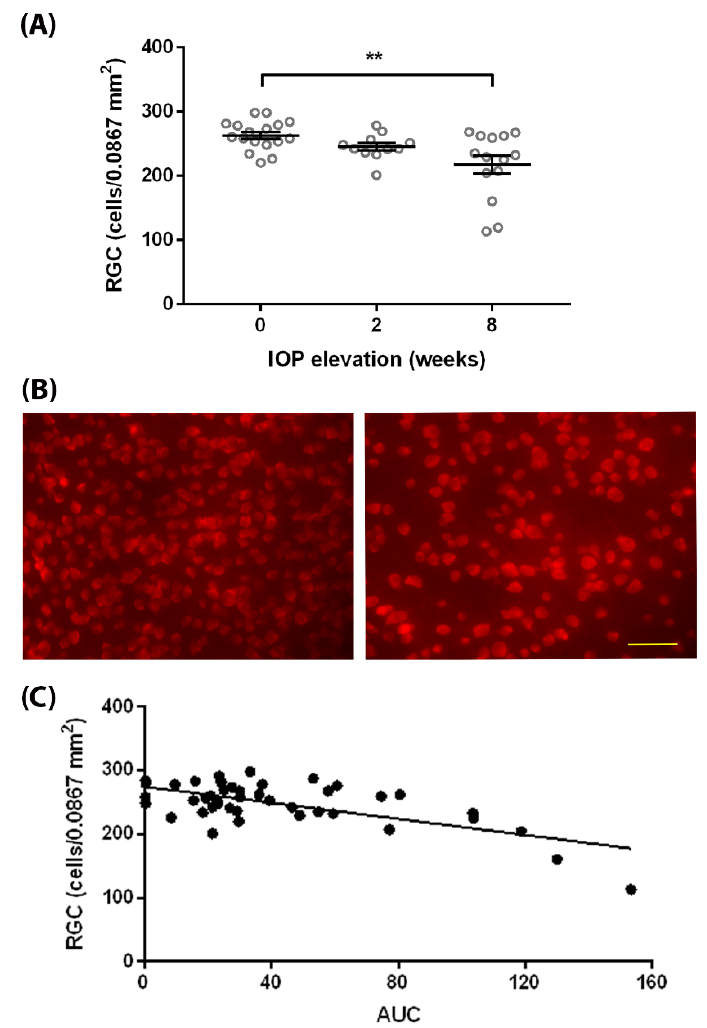
Figure 4. RGC degeneration in egl1 mice. ( A ) Quantification of RGCs was performed before and at 2 and 8 weeks after IOP elevation. Significant RGC loss was observed after 8 weeks of IOP elevation. Data are presented as means ± SEM ( n = 11–17). **: p < 0.01. ( B ) Representative images show RBPMS (red) immunolabeled retinal whole mounts from mice before ( left ) and 8 weeks after ( right ) IOP elevation. The density of RGCs, demonstrated by RBPMS positive cells, decreased after 8 weeks of IOP elevation. Scale bar = 50 µ m. ( C ) Individual RGC count was plotted against IOP exposure described as AUC. There was a moderate negative correlation between RGC counts and IOP exposure. R square: 0.43, p < 0.001.